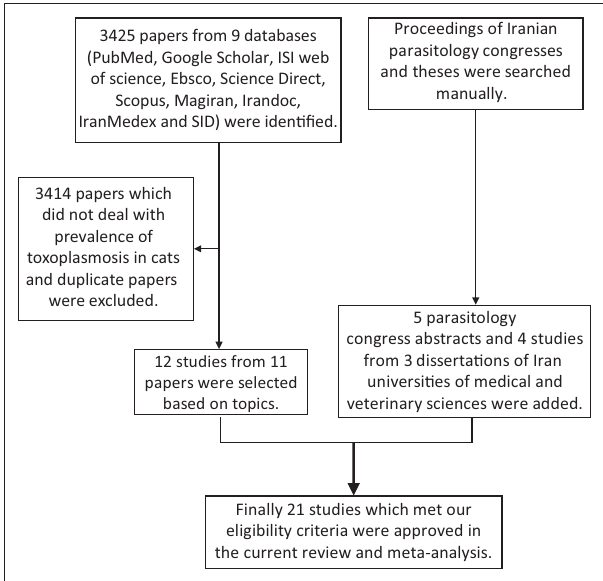
FIGURE 1: Flowchart describing the study design